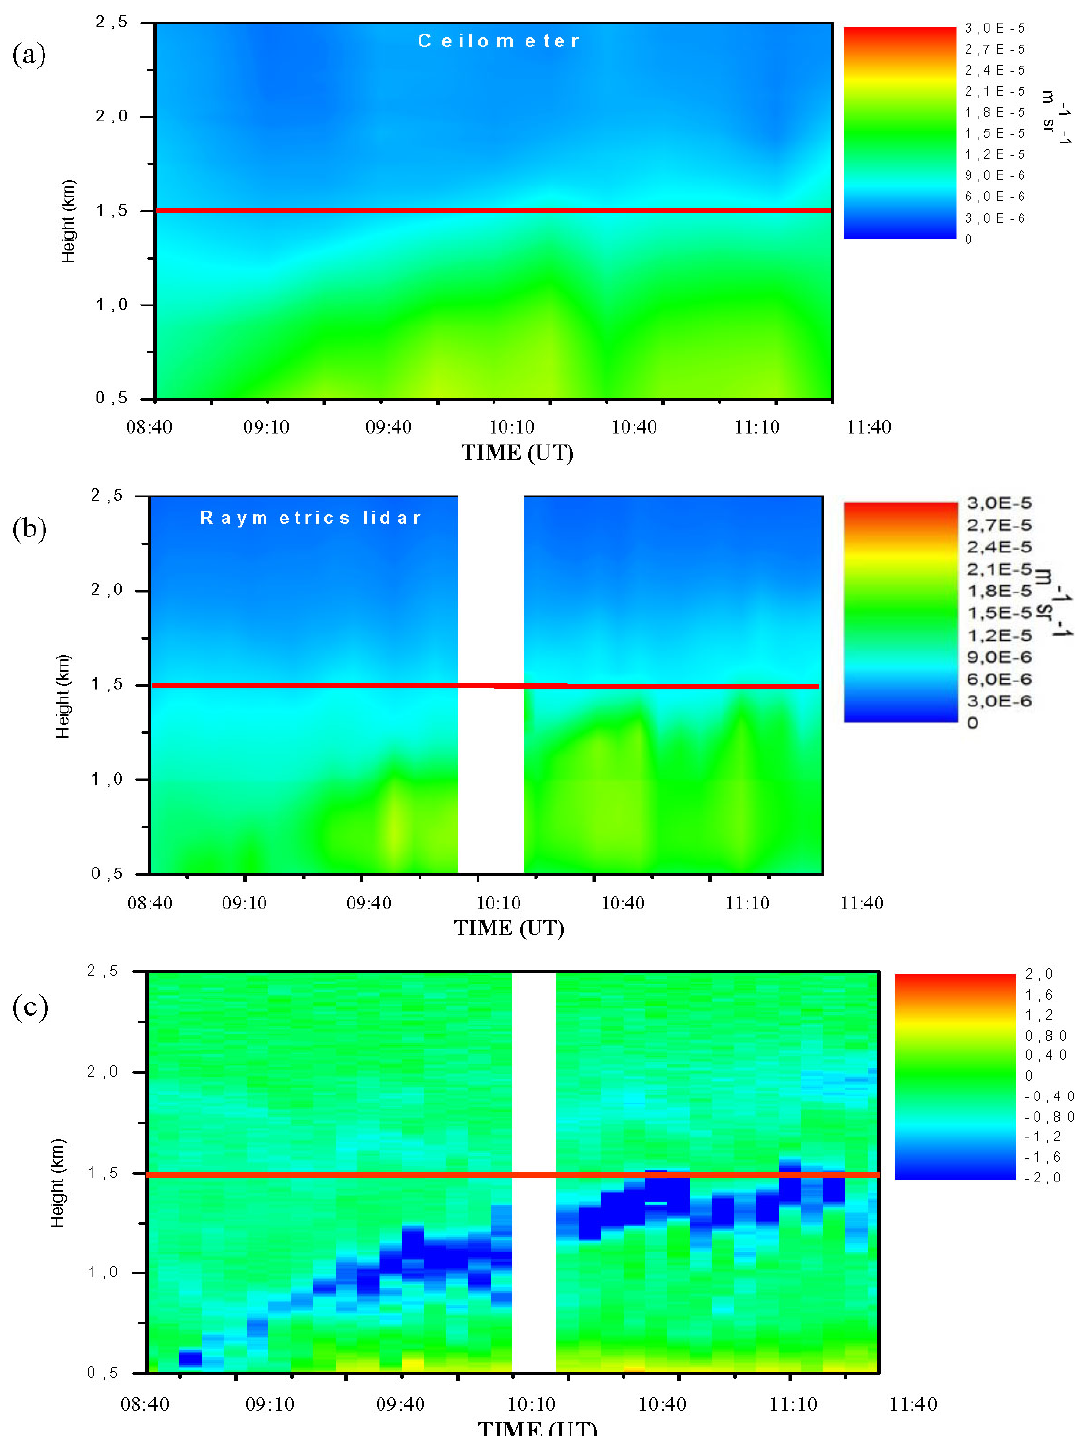
Fig. 2. Attenuated backscatter coefficient (in m − 1 sr − 1 ) obtained (a) by the ceilometer and (b) the Raymetrics lidar. (c) The first derivative of the logarithm of the range-corrected lidar signal (in arbitrary units: A.U.) obtained by the Raymetrics system. Time height cross sections are valid from 08:40UT to 11:40UT on 27 November 2008. Red lines represent mean PBL height around 11:00UT.